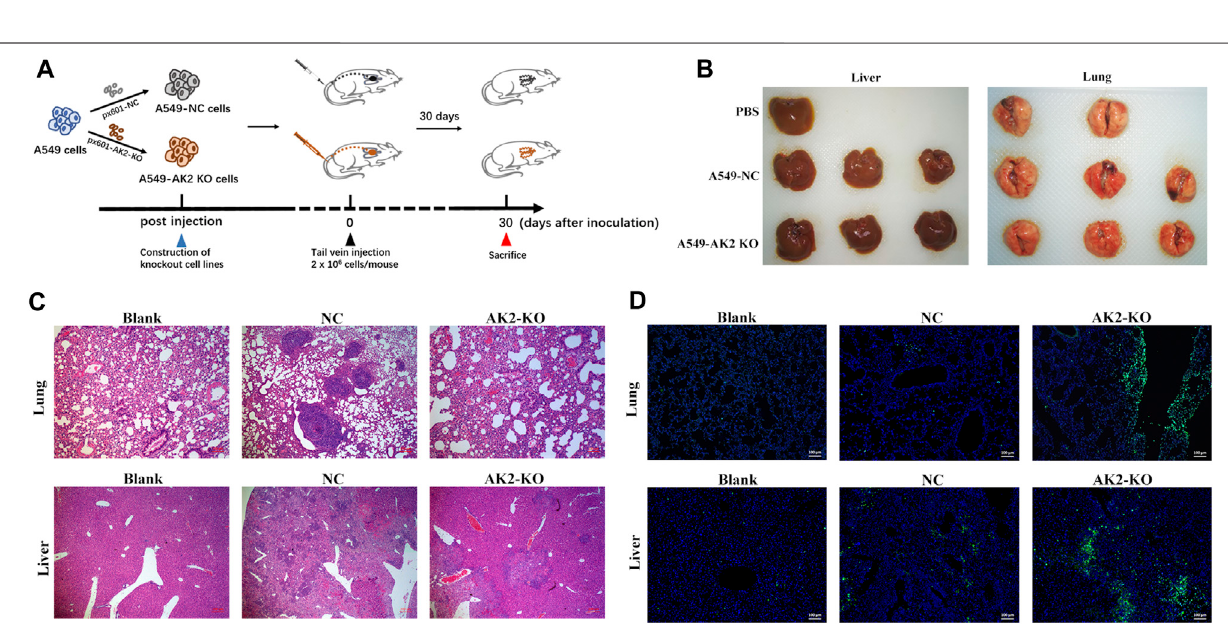
Frontiers in Pharmacology |